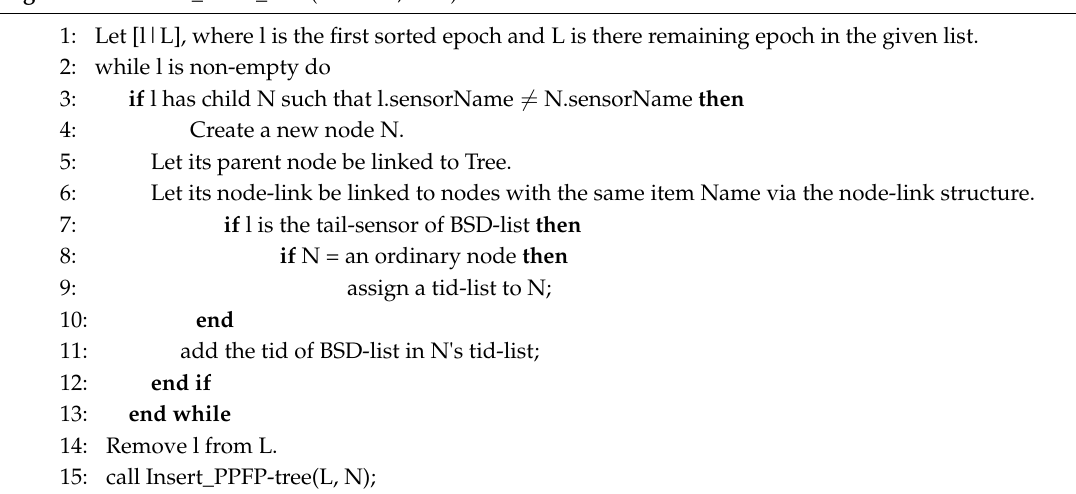
Algorithm 2: Insert_PPFP_tree (BSD-list,